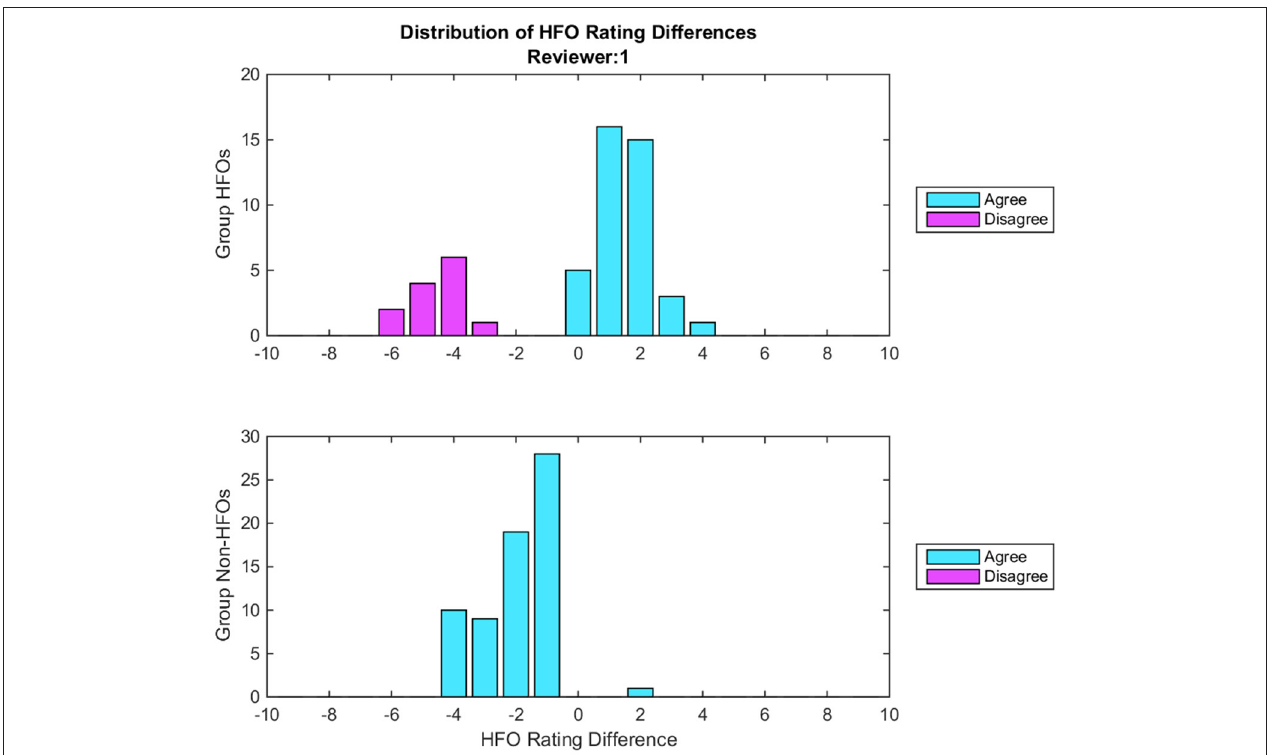
FIGURE 2 | Example of histograms given during the feedback for one reviewer. Each histogram illustrates the distribution of the differences between the group consensus and the reviewer’s HFO ratings. Cyan bars indicate epochs where there was agreement between the reviewer and the group consensus on whether an HFO is present, while magenta bars indicate disagreement. The zero bin indicates epochs where the reviewer’s rating matches the group consensus. Positive bins indicate epochs that the reviewer had marked as more likely containing an HFO than the group consensus, where the magnitude equals the difference between the group consensus and the reviewer’s rating. Negative bins indicate epochs that the reviewer had marked as less likely containing an HFO. The top histogram represents epochs marked by the Group DIs containing HFOs, while the bottom histogram reflects those marked by the Group DIs not containing HFOs. In this particular example, the top histogram illustrates that when the group marked an HFO, the reviewer agreed 75% of the time; this is indicated by 75% of the bars being cyan, and only 25% being magenta. In all cases of agreement, the reviewer was more certain than the consensus, typically by 1 or 2 confidence points. The bottom histogram here illustrates that when the group marked a non-HFO, the reviewer agreed 100% of the time, and was more confident than the group consensus in all but one instance, again typically by 1 or 2 confidence points. Overall, this reviewer rates both HFOs and non-HFOs confidently, but is generally less likely to identify an event as an HFO than the group on